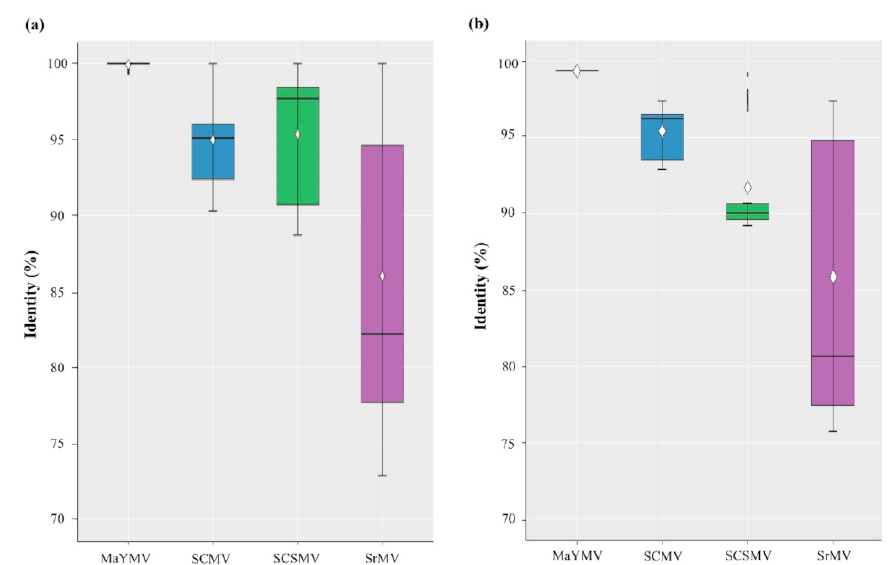
Figure 2. Nucleotide sequence identity of targeted fragments amplified from SrMV, SCMV, SCSMV, and MaYMV with virus reference sequences. ( a ) Comparison of targeted fragment sequences within